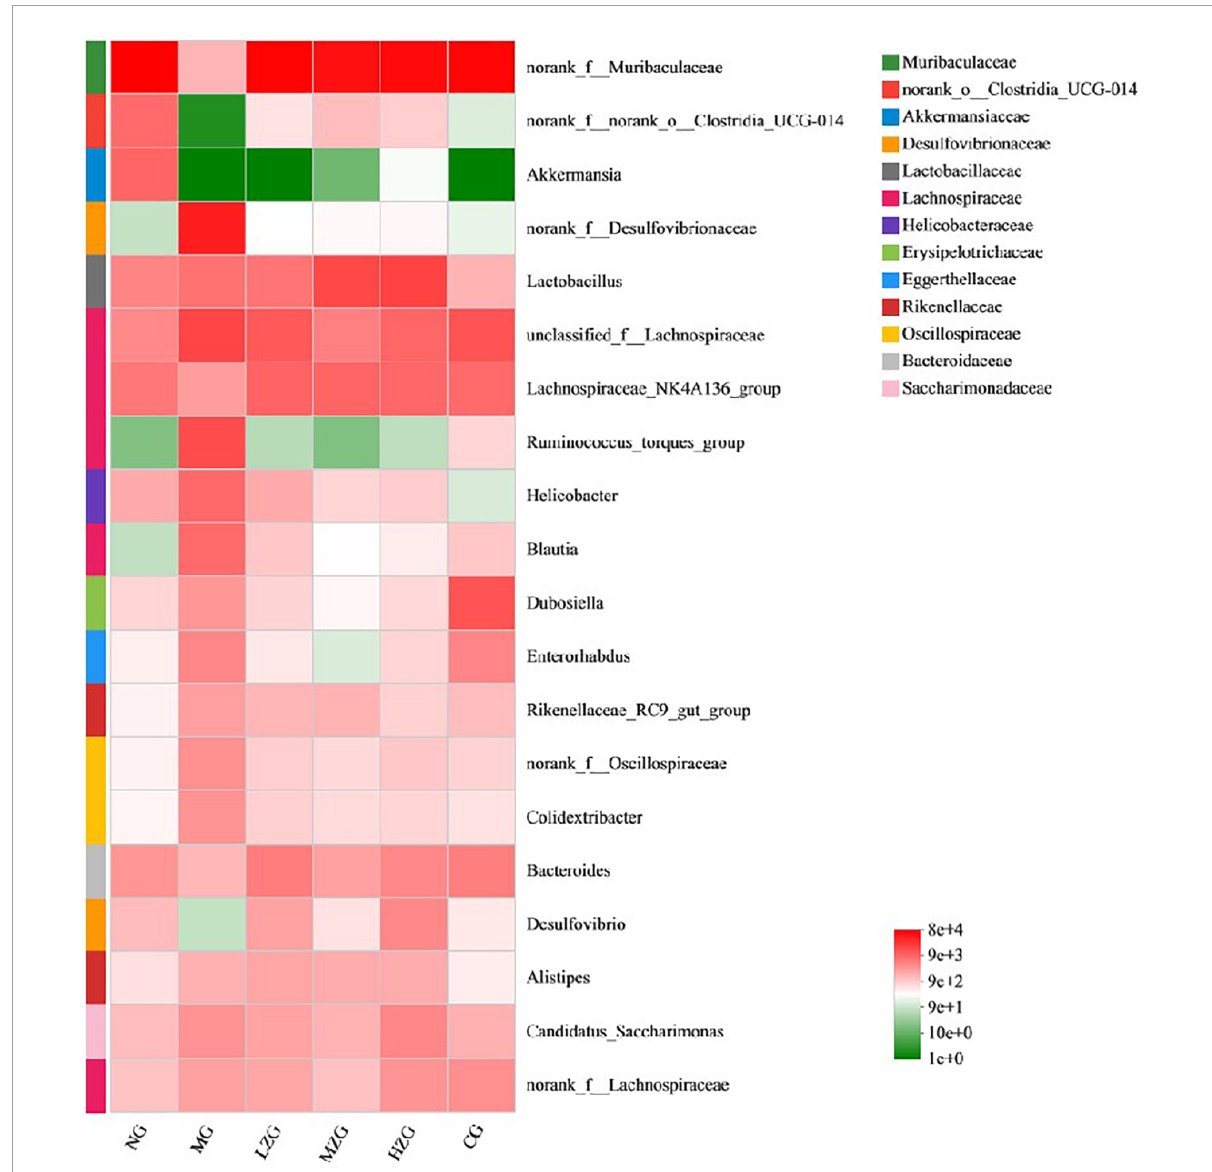
FIGURE7 Heat map of gut microbial composition at the genus level. The abscissa is the group name, and the ordinate is the species name. The abundance changes of different species in the sample are displayed through the color gradient of the color block. The right side of the figure is the value represented by the color